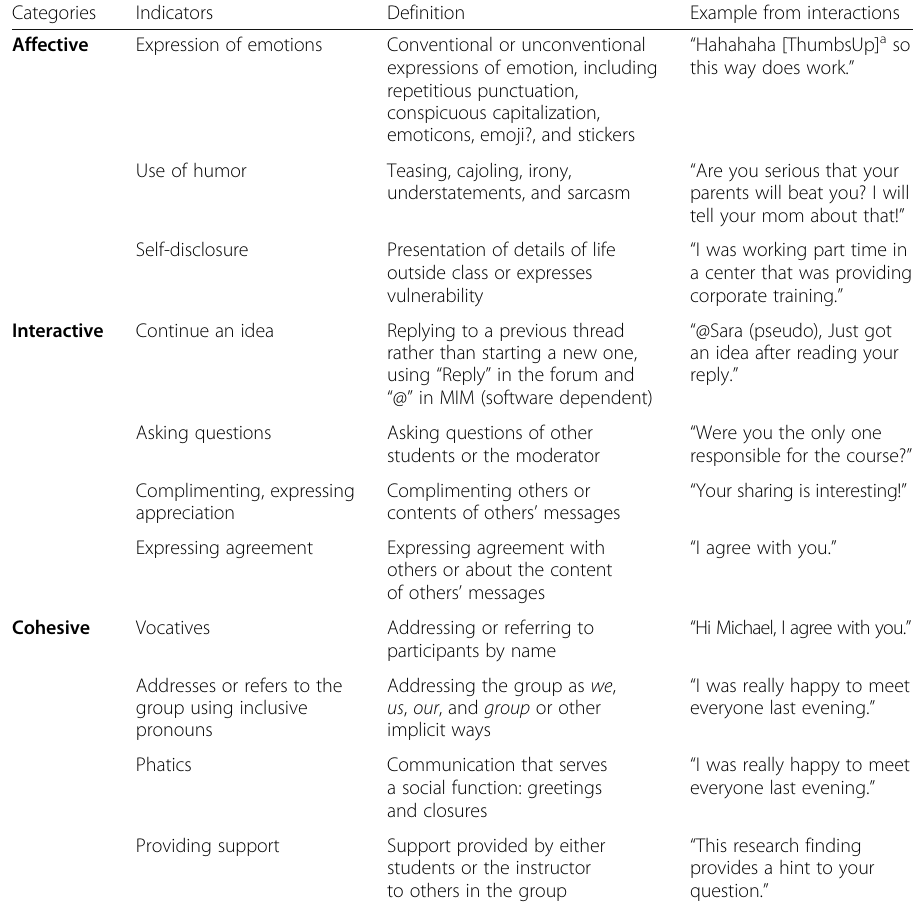
Table 1 Categories and indicators of social presence Categories